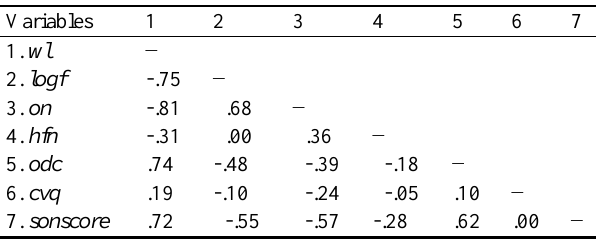
Table 2 . Correlations between Seven QNA Features